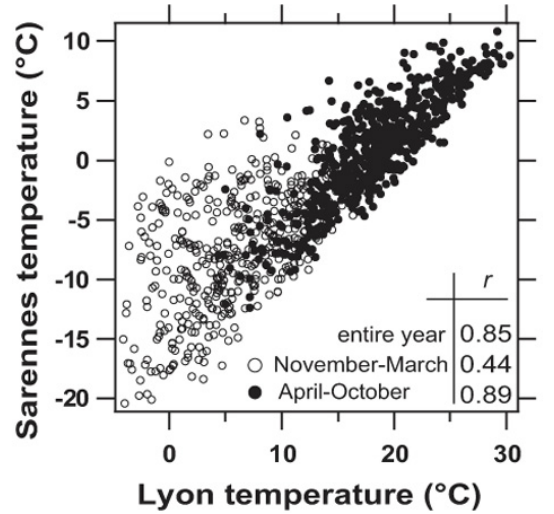
Fig. 3. Correlation between daily temperatures measured at Sarennes (3070m) and Lyon-Bron (200ma.s.l.) recorded over